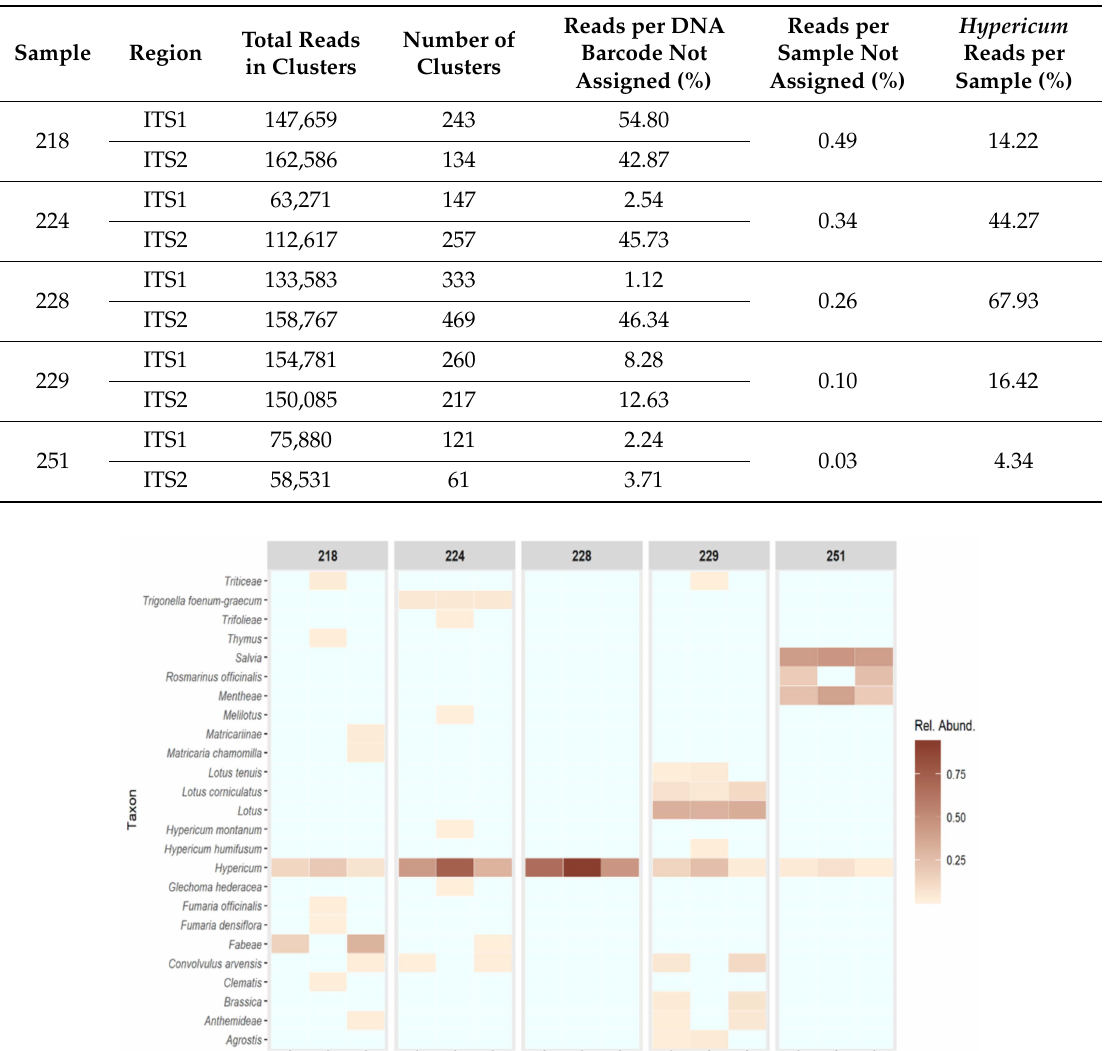
Table 5. The total number of filtered and clustered reads per sample as analysed by metabarcoding. The number of clusters and the percent of ‘not assigned’ reads are summarised, and the percentage of Hypericum reads per sample shown.